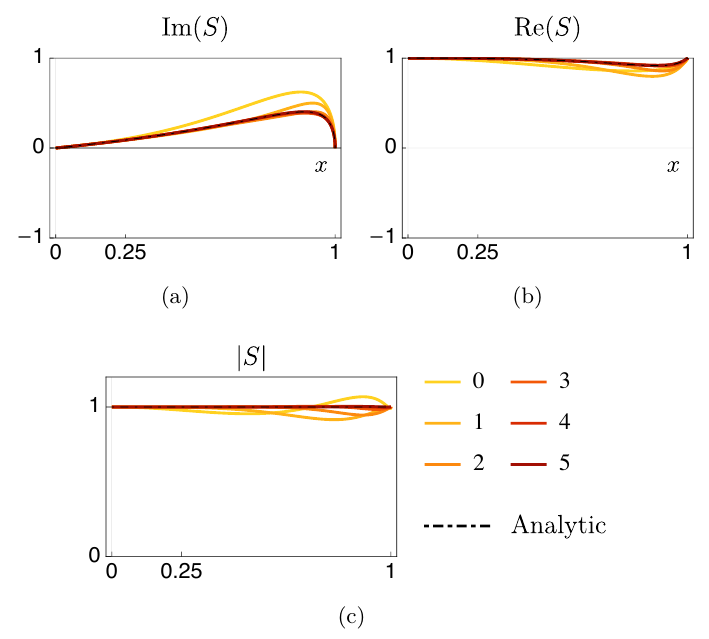
Figure 3 . Results of the iterations for one bound state and fixed constant at infinity. Obtained for c = 1 . 25 , m 2 = 2 . 8 . We show only first 5 iterations. The analytical solution is given by (2.10) ∞ p with S = S pole with m 2 S zero ’ 3 . 594 . . . , the value which solves (2.12) with v i = 0 . elastic z CDD CDD